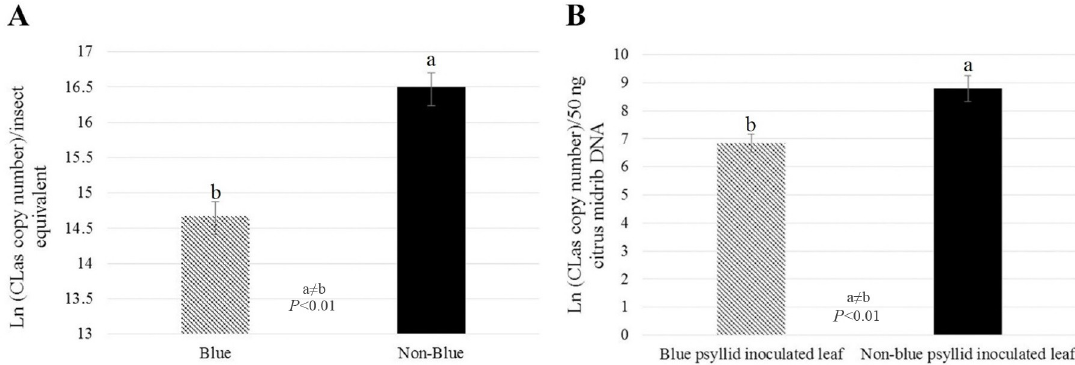
Fig 4. C Las titer in blue and non-blue color morphs of D . citri adults and in citrus leaves inoculated by blue and non-blue insects. (A) C Las copy number per insect equivalent is ~8-fold greater in non-blue compared to blue D . citri (P < 0.01). (B) C Las copy number in midrib DNA samples from citrus leaves inoculated with non-blue D . citri is ~6 fold greater than in leaves inoculated with blue D . citri (P <